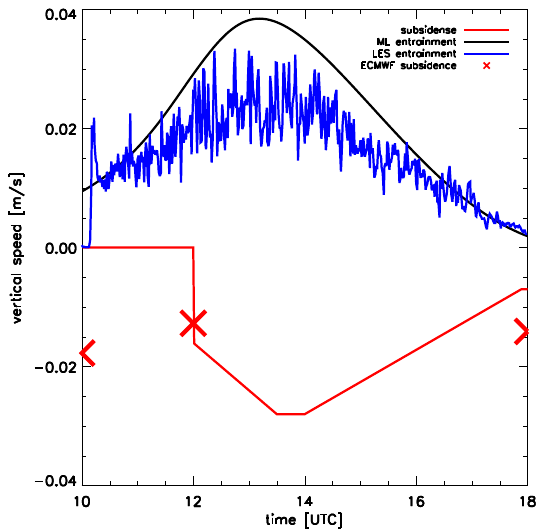
Figure 7. Temporal evolution of the entrainment velocity and pre- scribed subsidence velocities at the top of the boundary layer for the run with prescribed subsidence (case 2). The subsidence values calculated by ECMWF model are also